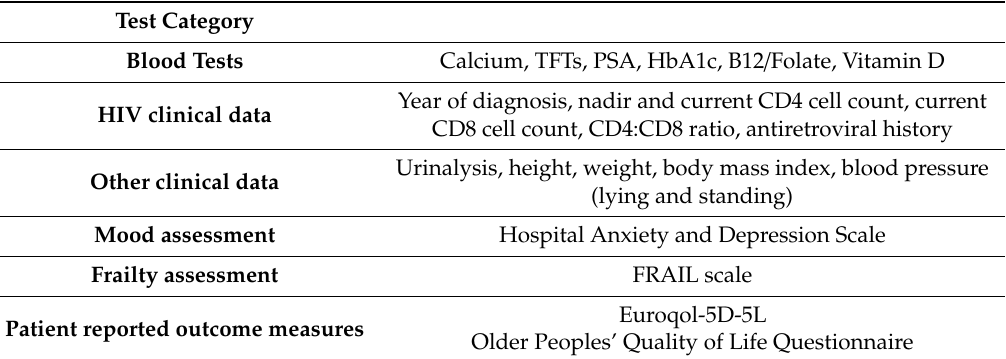
Table 1. Clinical assessments performed within the Silver